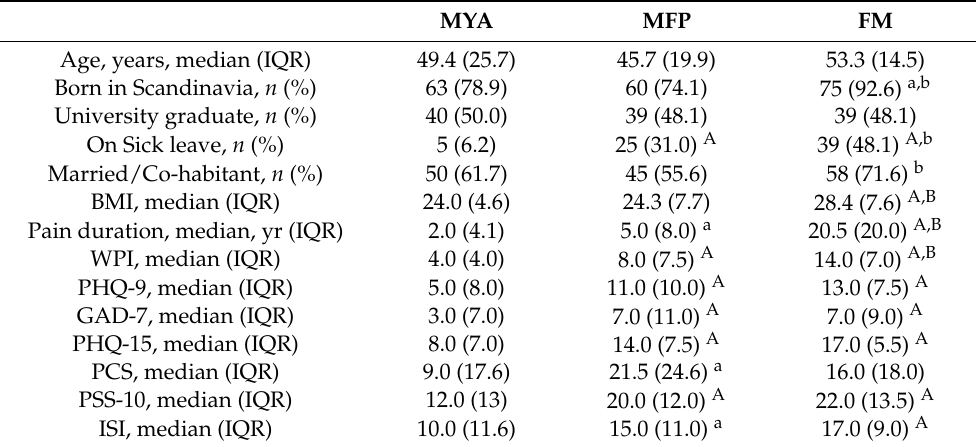
Table 1. Descriptive characteristics of 80 women with myalgia (MYA), 81 with myofascial pain (MFP), and 81 with fibromyalgia